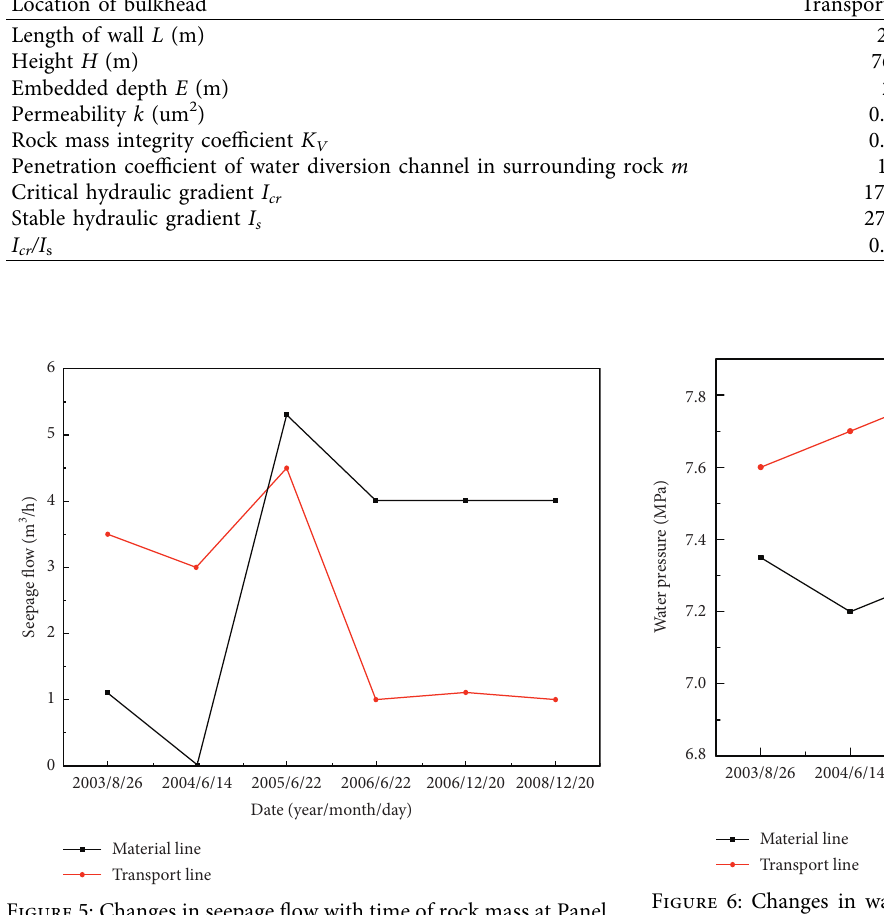
Table 10: Parameters to calculate hydraulic gradient of the surrounding rocks in Sanhejian coal mine. Location of bulkhead